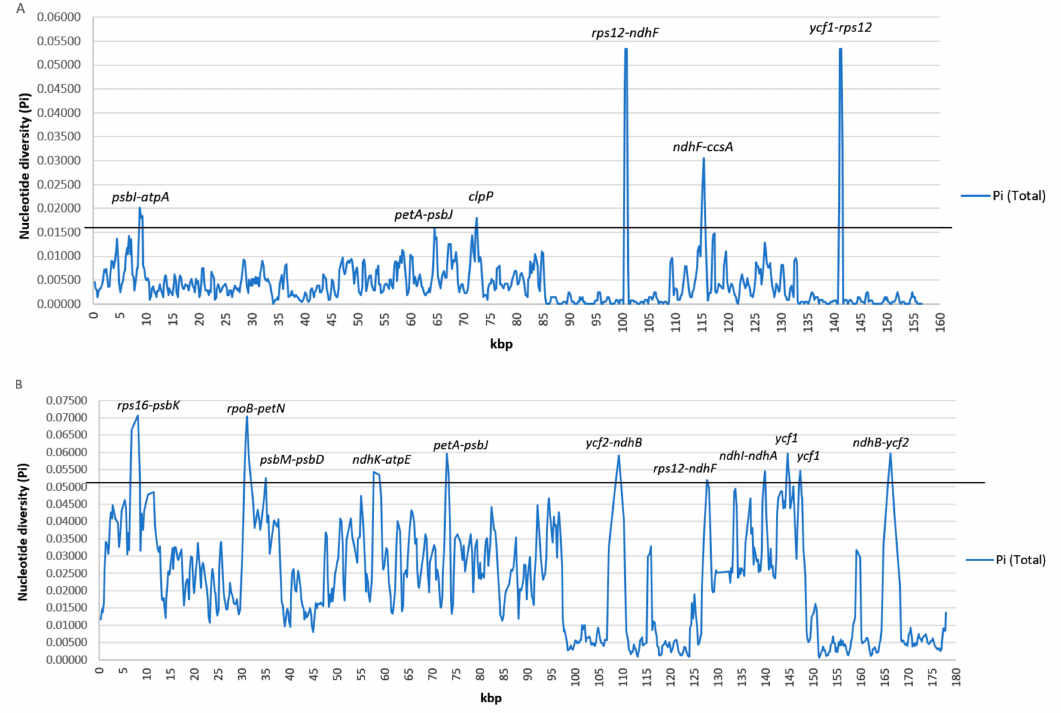
Figure 3. Sliding window analysis of the whole chloroplast genomes. Window length: 600 bp; step size: 200 bp. X -axis: position of the midpoint of a window. Y -axis: nucleotide diversity of each window. ( A ) Pi between seven Dracaena species. ( B) Pi among all 16 representatives of Asparagales. The black horizontal line on the graph sets the threshold separately for Dracaena (0.0152) and separately for Asparagales